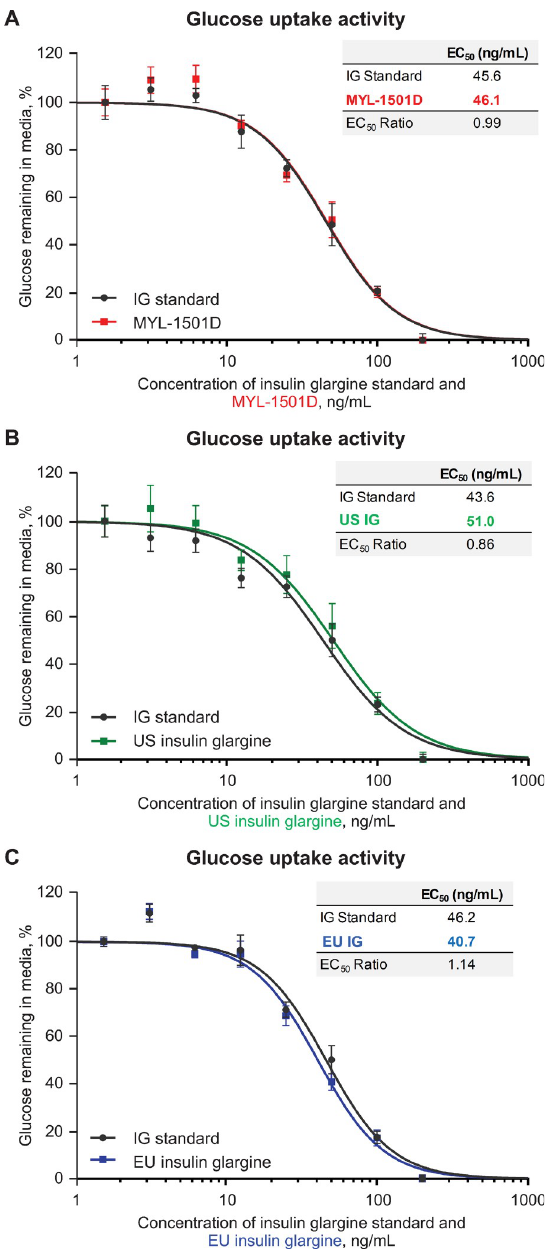
Fig 13. Representative dose-response curves of enzymatic glucose uptake assay in 3T3-L1 cells. (A) MYL-1501D, (B) US-Licensed Insulin Glargine, and (C) EU-Licensed Insulin Glargine. All samples were analyzed against a common insulin glargine reference standard (IG standard) to normalize against day-to-day variability. Each lot was analyzed using 3 independent dilution preparations on an assay plate. Mean ± SEM for the % glucose remaining in the media is plotted (y-axis) against the concentration (x-axis). Four parameter logistic curve fit was applied to evaluate EC 50 . Each sample was analyzed on 3 independent assay plates, and average is reported. EC 50 , half maximal effective concentration.